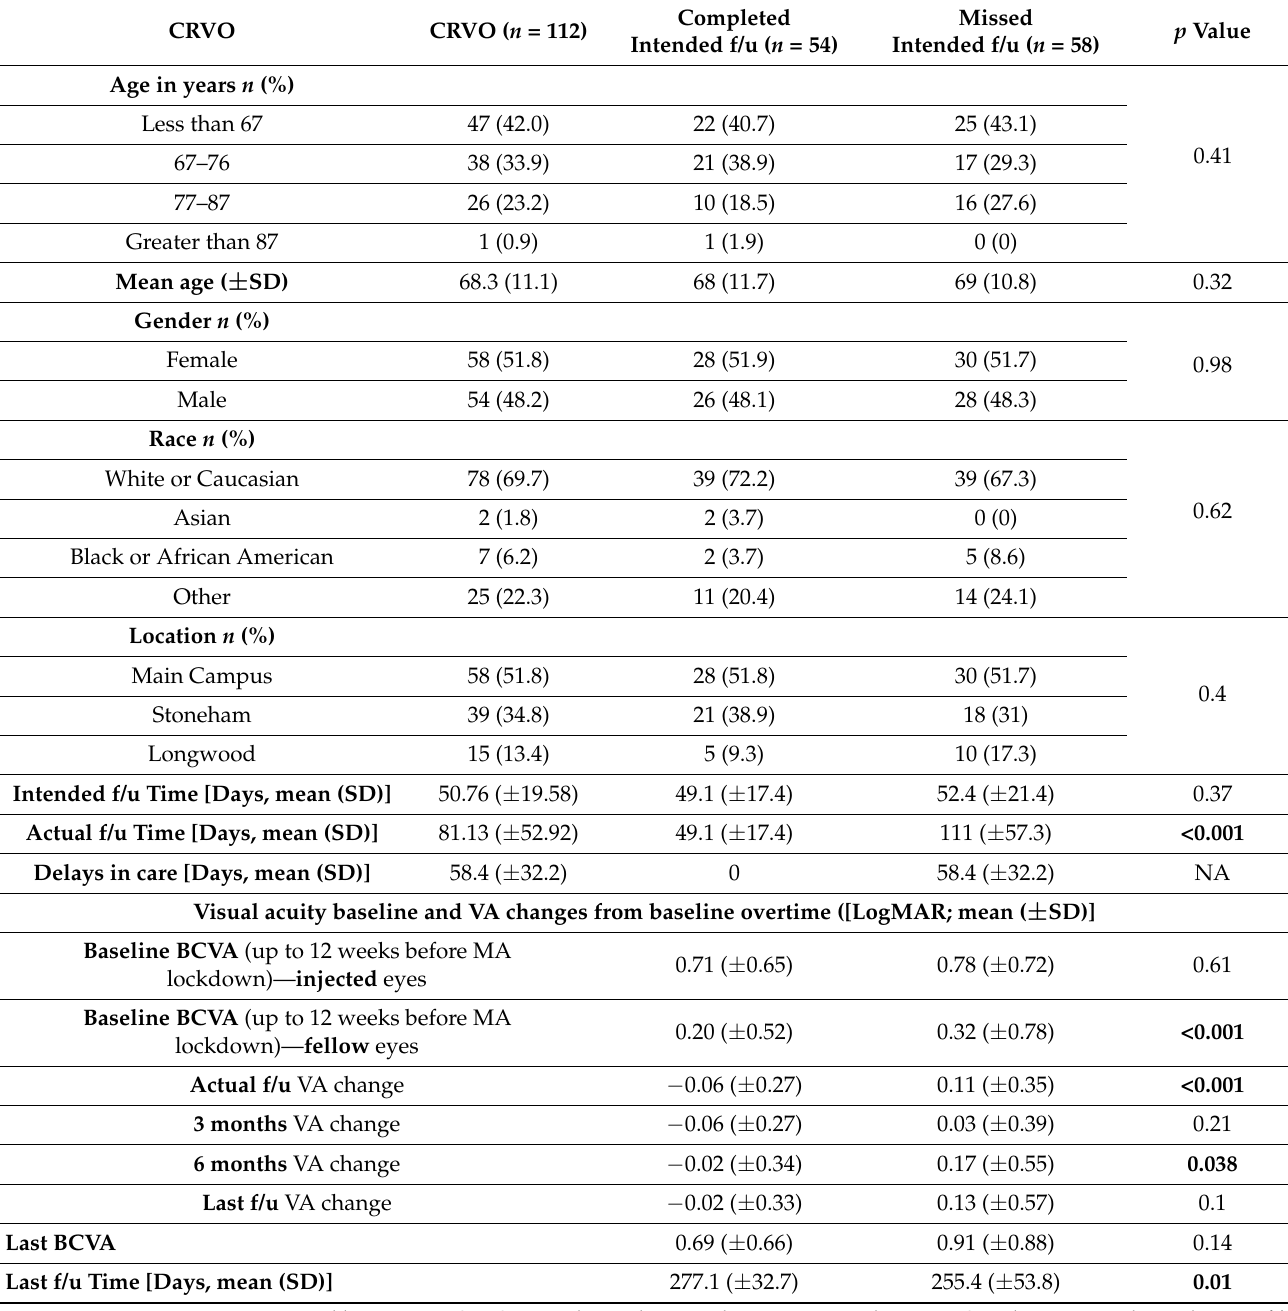
Table 4. Demographic and clinical characteristics of CRVO